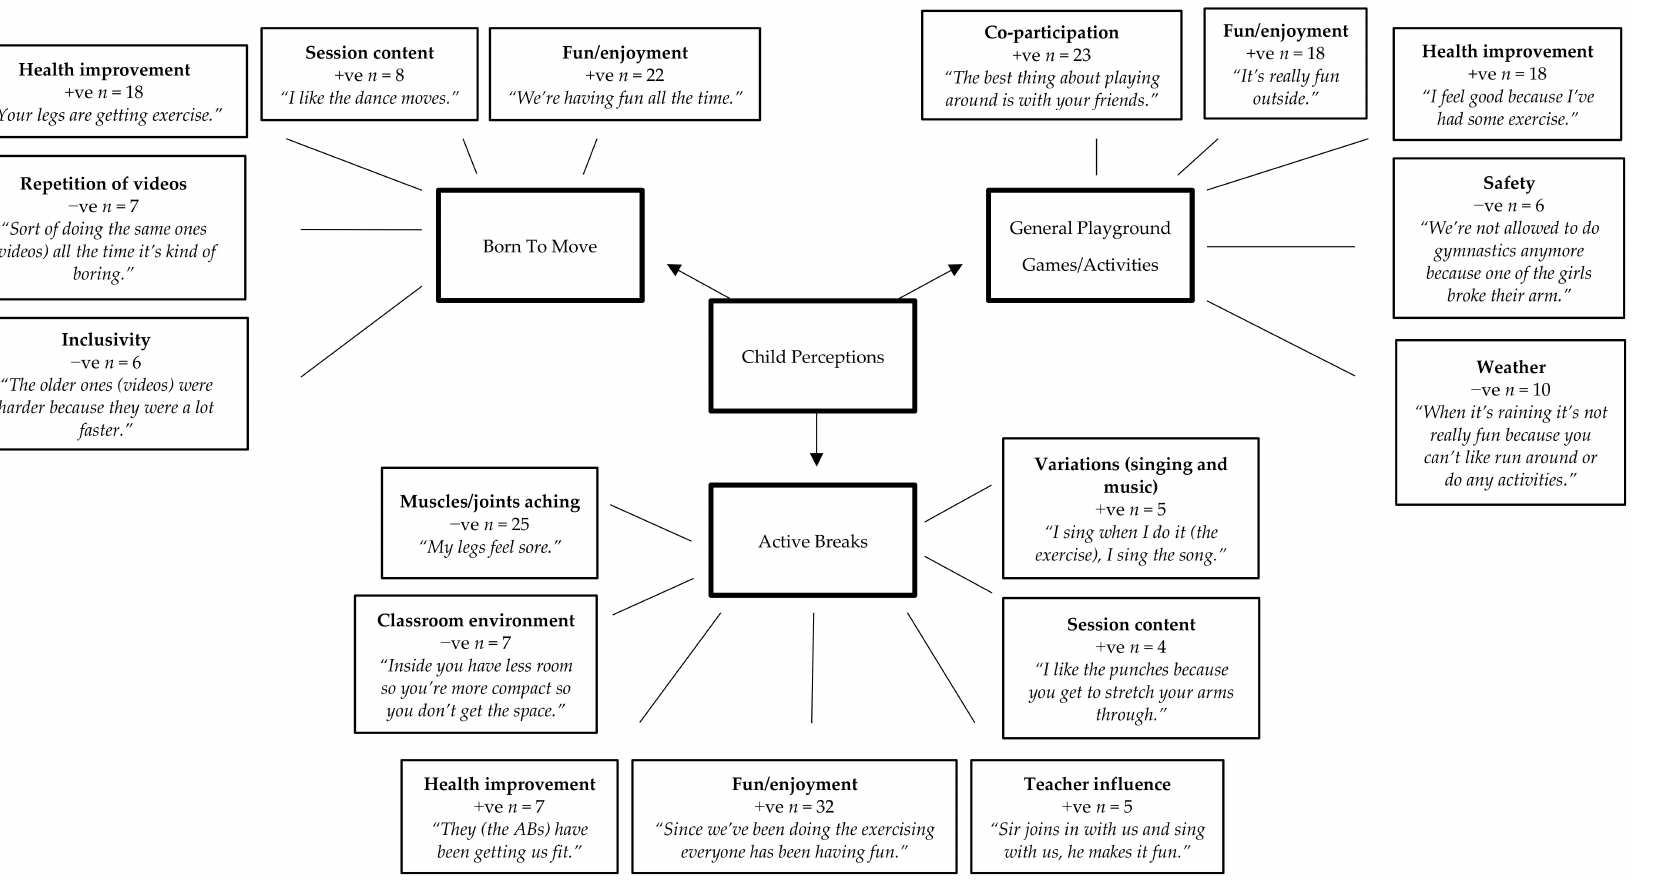
Figure 1. Children’s perceptions of each intervention. +ve = positive. − ve =